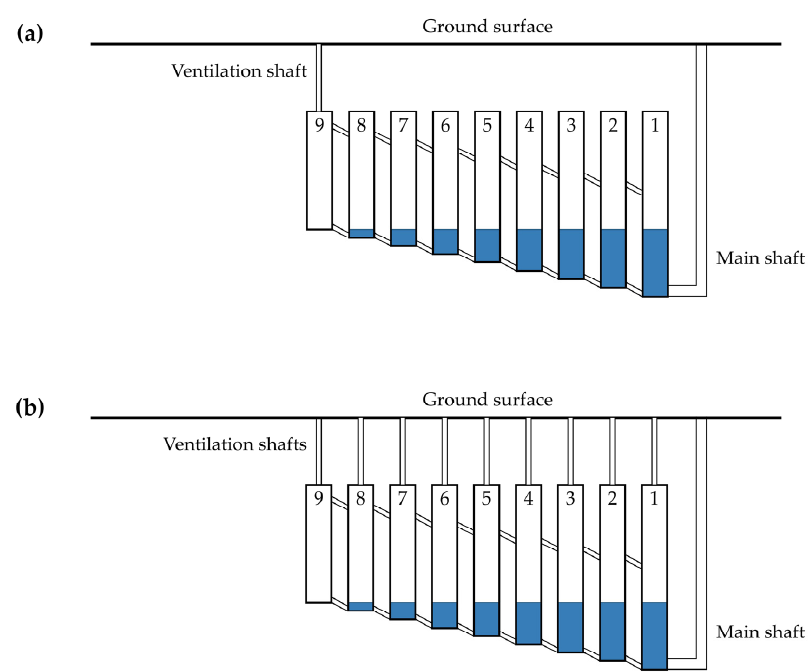
Figure 2. Sketch of the nine underground chambers used as underground reservoir of an underground pumped storage hydropower (UPSH) for ( a ) partially aerated and ( b ) fully aerated chambers. The ventilation shaft in ( a ) has a rectangular cross-section with 1.5 × 1.5 m 2 while the ventilation shafts in ( b ) are considered large enough to secure atmospheric pressure in the chambers. The water level corresponds to the initial conditions of the simulations. Table 1. Geometric characteristics of the chambers of the Martelange slate mine. Various geometry scenarios were examined to infer the variability of water levels in the nine 166 underground chambers. The number and location of the connecting galleries remained the same in 167 every numerical simulation (Figure 2). The total cross sectional area of the two connecting galleries 168 varied from 5 to 40 m 2 with a roughness height equal to 5 cm, while for some cases the roughness 169 height was increased to 20 cm, as shown in Table 2. All cases were simulated for partially and fully 170 aerated conditions. 171 Table 2. Examined scenarios in numerical simulations 172